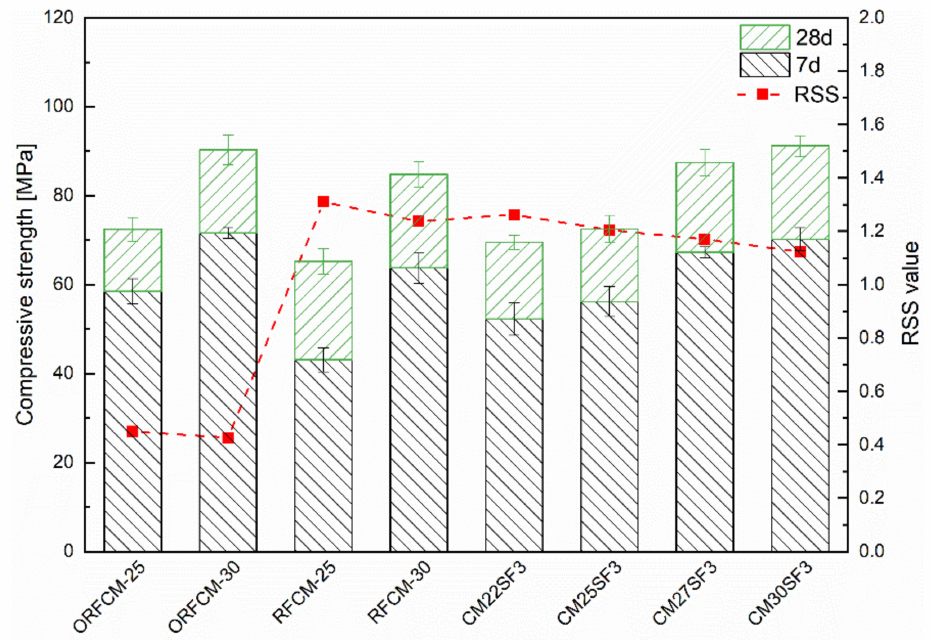
Figure 15. Relationship between compressive strength and packing